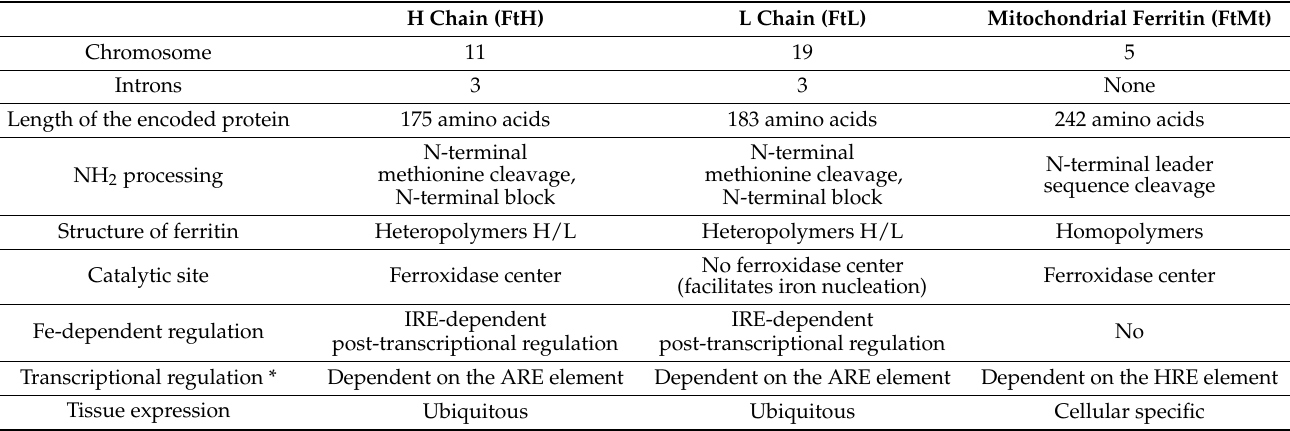
Table 1. The major differences among cytosolic and mitochondrial